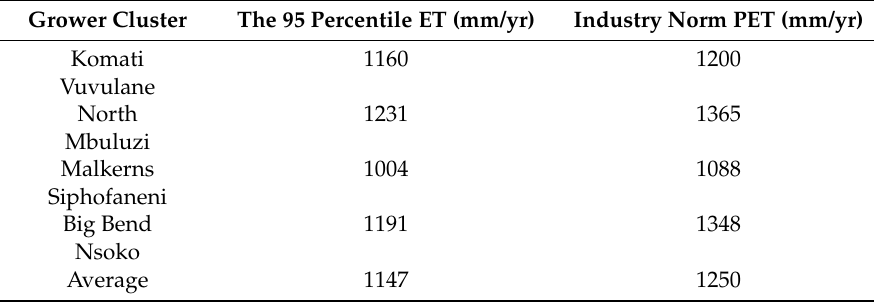
Table 3. Comparison of the industry norm PET and the 95 percentile ET